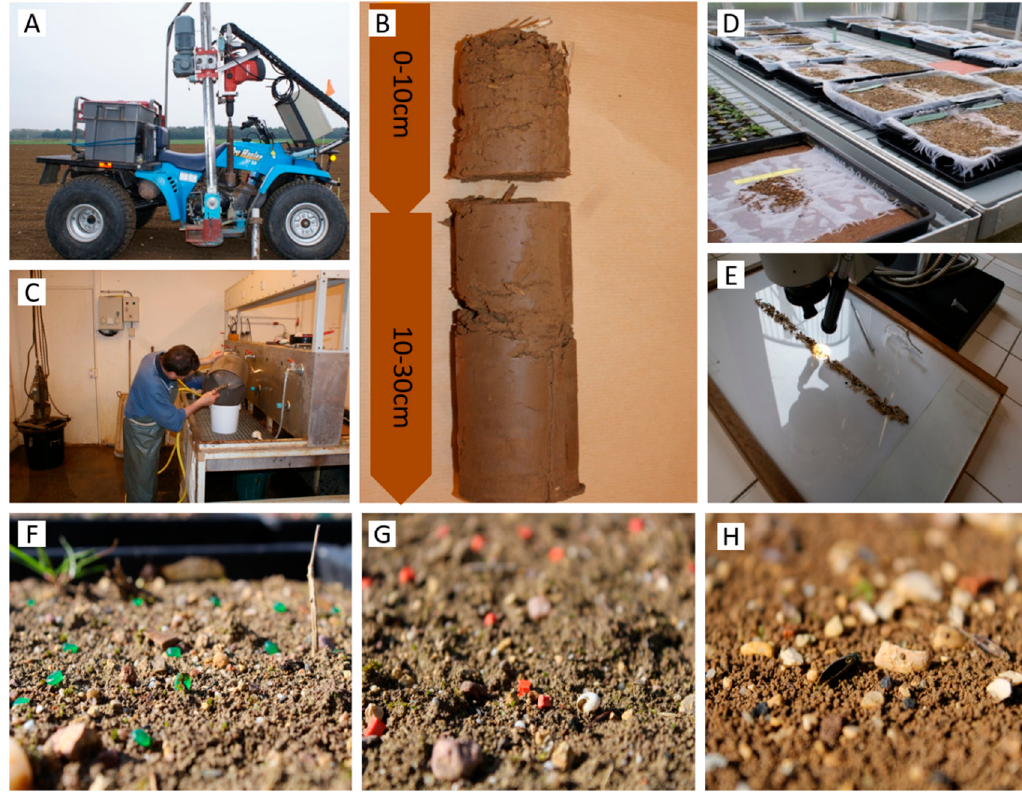
Figure 2. Seedbank assessment before and after tillage operations. ( A ) Soil sampling with an auger. ( B ) Separation of the superficial and deep horizons. ( C ) Extraction of weed seeds using the sieving method. ( D ) Greenhouse germination bioassay of the previously extracted seeds. ( E ) Identification and counting of non-germinated seeds under a binocular magnifier. Coloured plastic beads of different sizes, weights, and densities could be placed on the soil surface prior to tillage ( F , G ) so as to mimic weed seeds ( H ), and allow the assessment of their vertical distribution after tillage, potentially highlighting incomplete burial. Copyright (c) INRAE.